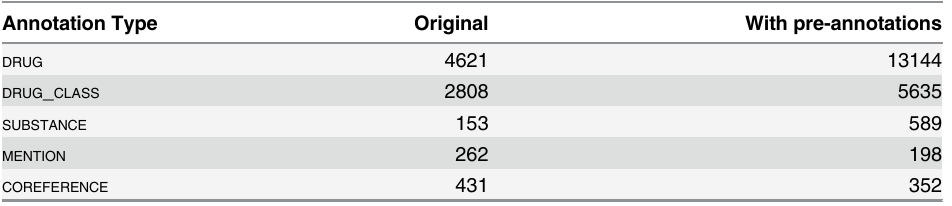
Table 1. Number of annotations before and after